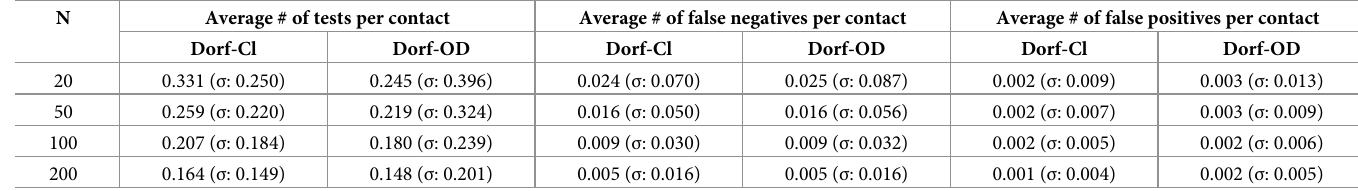
Table 1. Average numbers of tests, false negatives and false positives achieved by our method (Dorf-OD) and classic Dorfman’s method (Dorf-Cl) for various values of the number of contacts N. Here, we sample the number of secondary infections from a truncated negative binomial distribution with reproductive number R = 2.5 and dispersion parameter k = 0.1 [24] and, we set the sensitivity and specificity to s e = 0.8, s p = 0.98. For each combination of method and parameter values, the averages and standard deviations are estimated using 10,000 samples. N Average # of tests per contact Average # of false negatives per contact Average # of false positives per contact Dorf-Cl Dorf-OD Dorf-Cl Dorf-OD Dorf-Cl